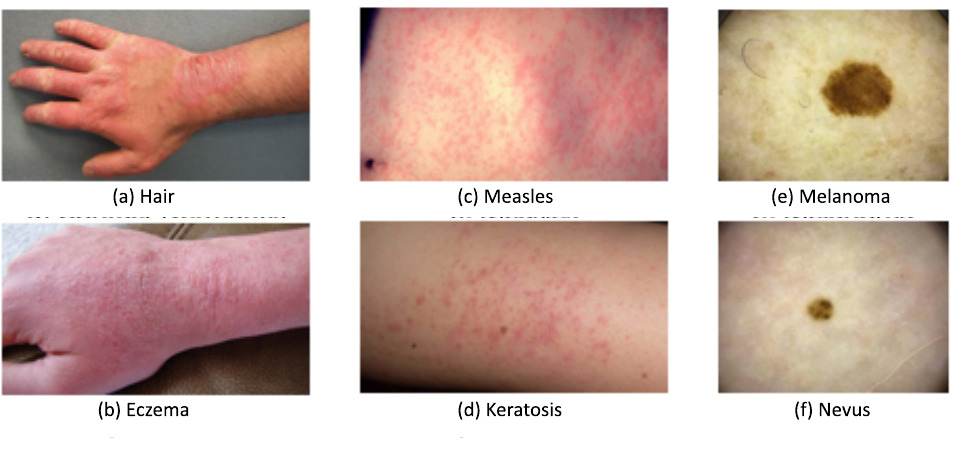
Figure 1. Common skin diseases